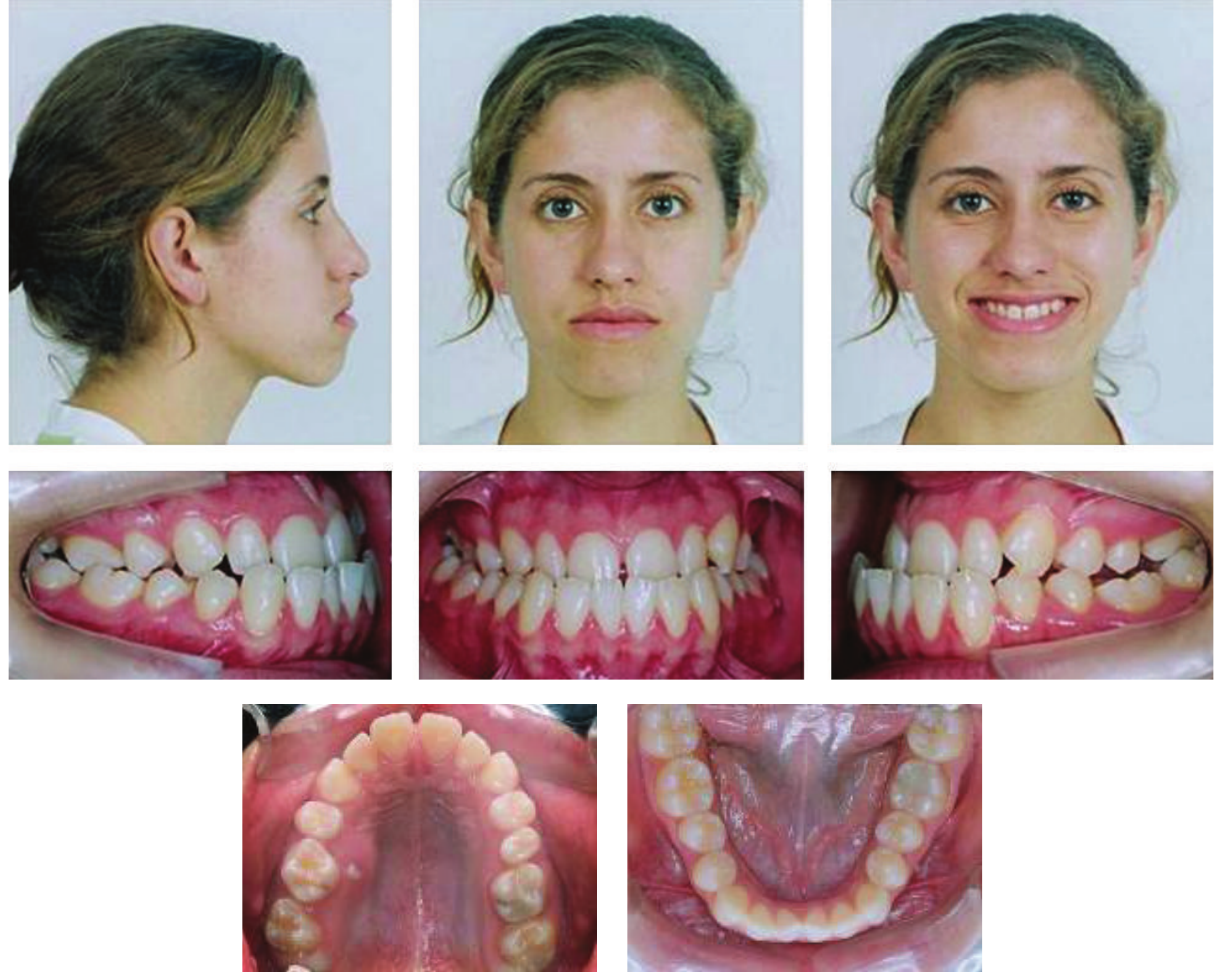
Figure 1: Pretreatment extraoral and intraoral